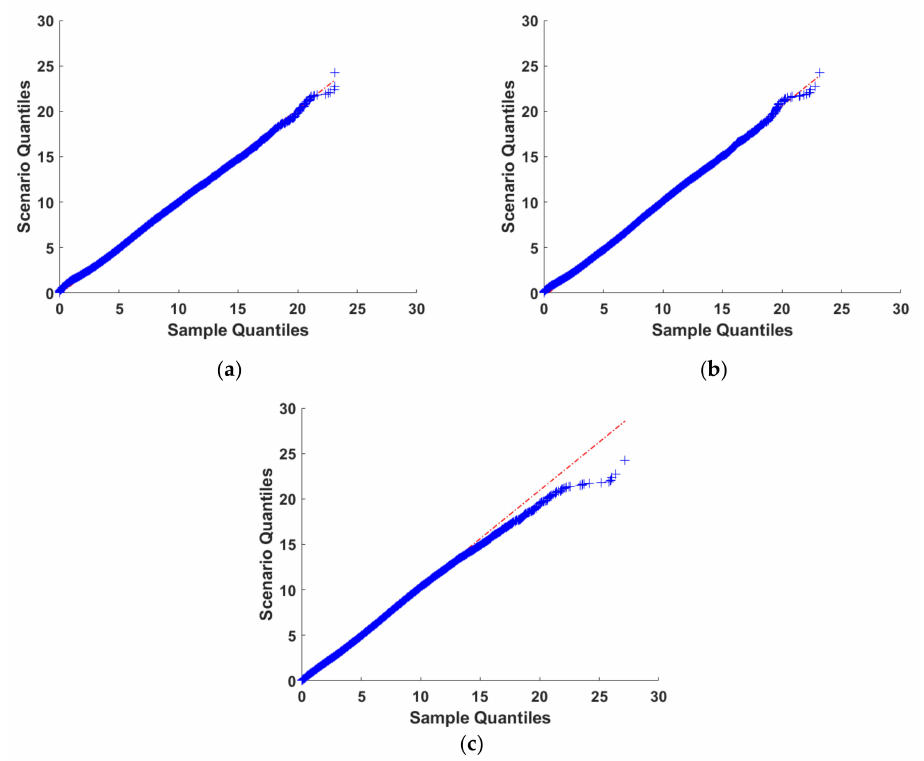
Figure 9. QQ plot for WF 1 of samples and scenarios generated using ( a ) the PC-R-vine model, ( b ) the PCA-ARMA model, ( c ) the HMCM model.